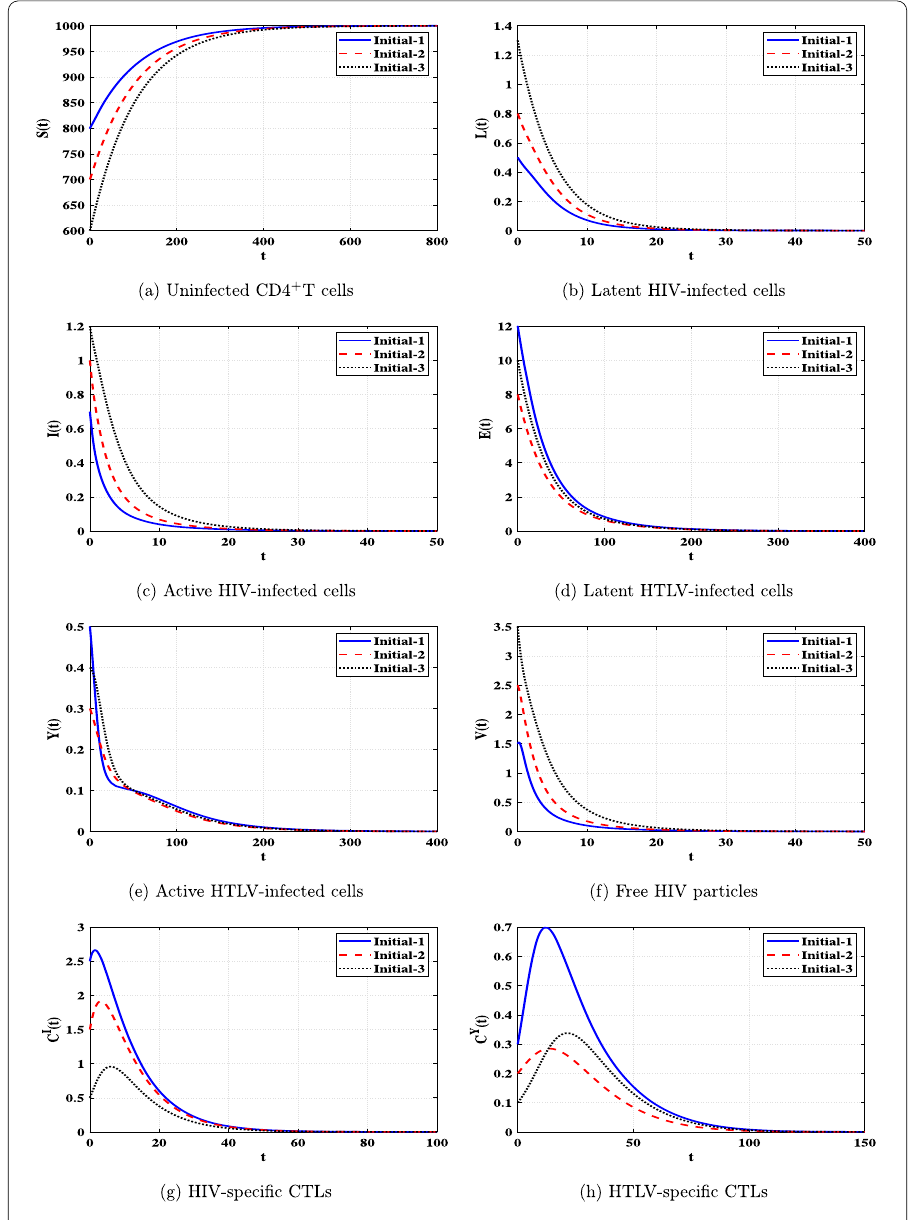
Figure 1 Solutions of system (29) when (cid:9) 1 ≤ 1 and (cid:9) 2 ≤